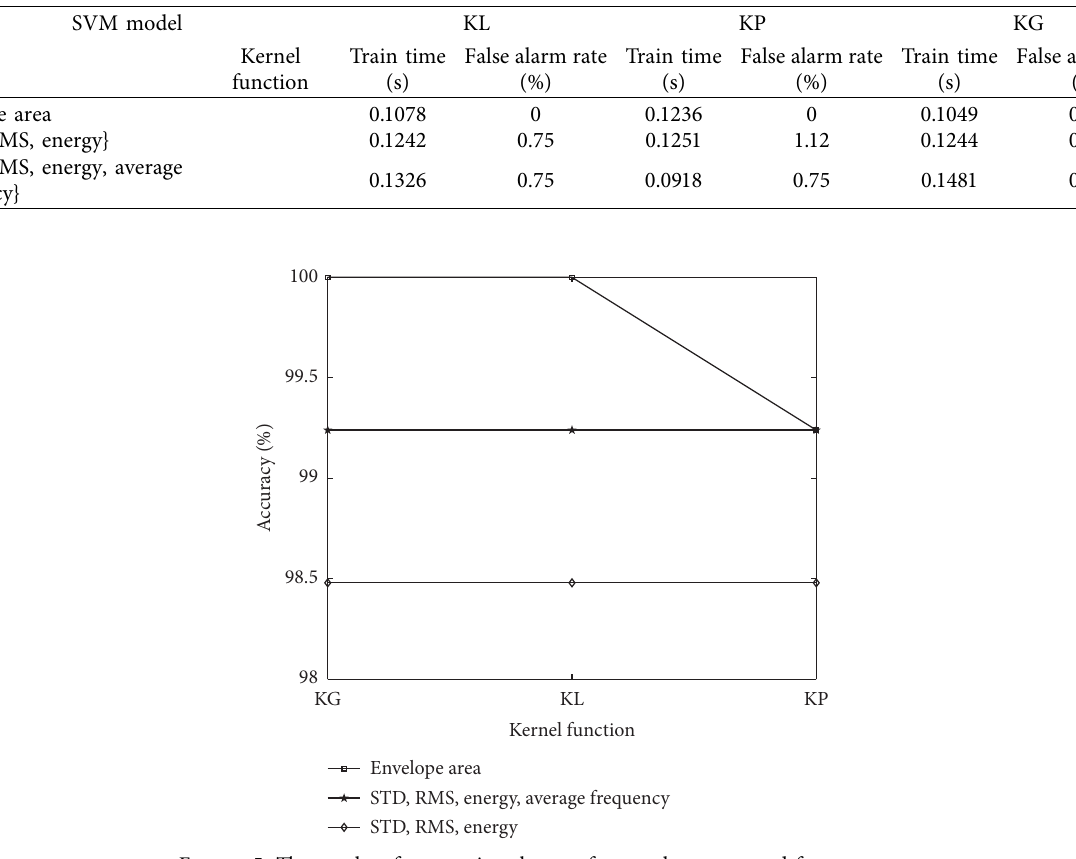
Table 2: Training time and overall accuracy for 3 kernel functions utilizing the training sets.